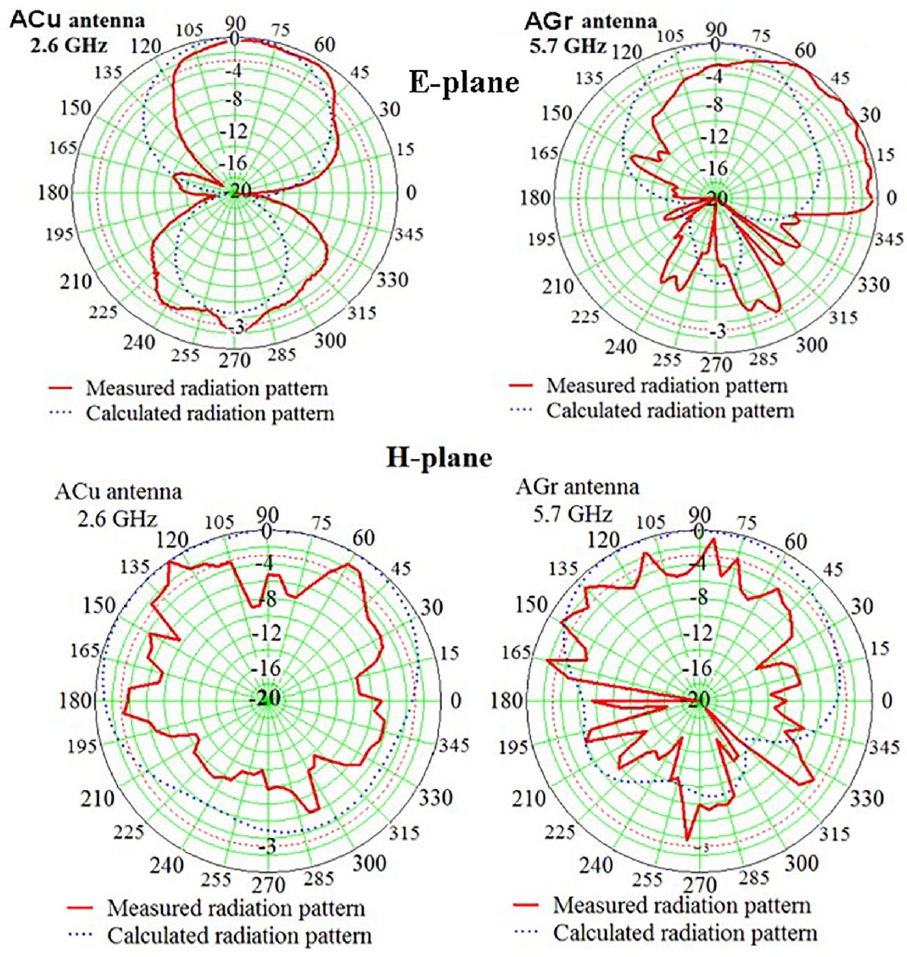
Figure 6. Radiation pattern of the ACu antenna for the frequency of 2.6 GHz and the AGr antenna for the frequency of 5.7 GHz in E- and H-planes. The frequency was chosen in accordance with the resonant peak position. The red dotted line corresponds to RP = − 3 dB.